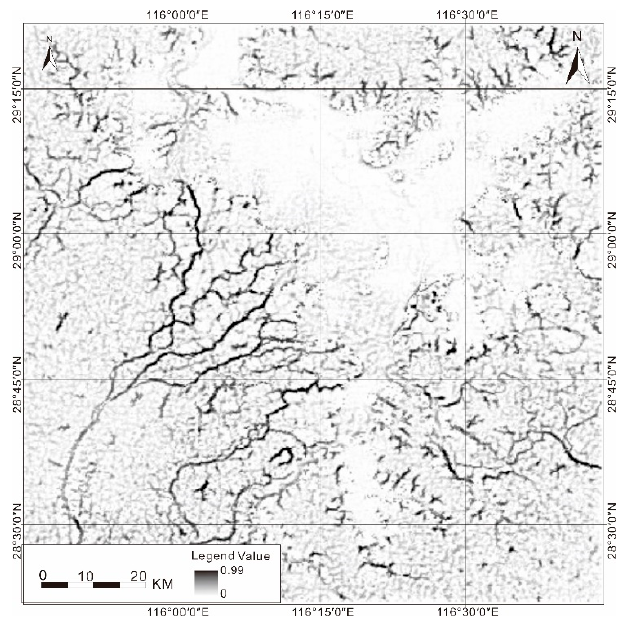
Figure 9. Linear feature enhancement result of the NDWI.